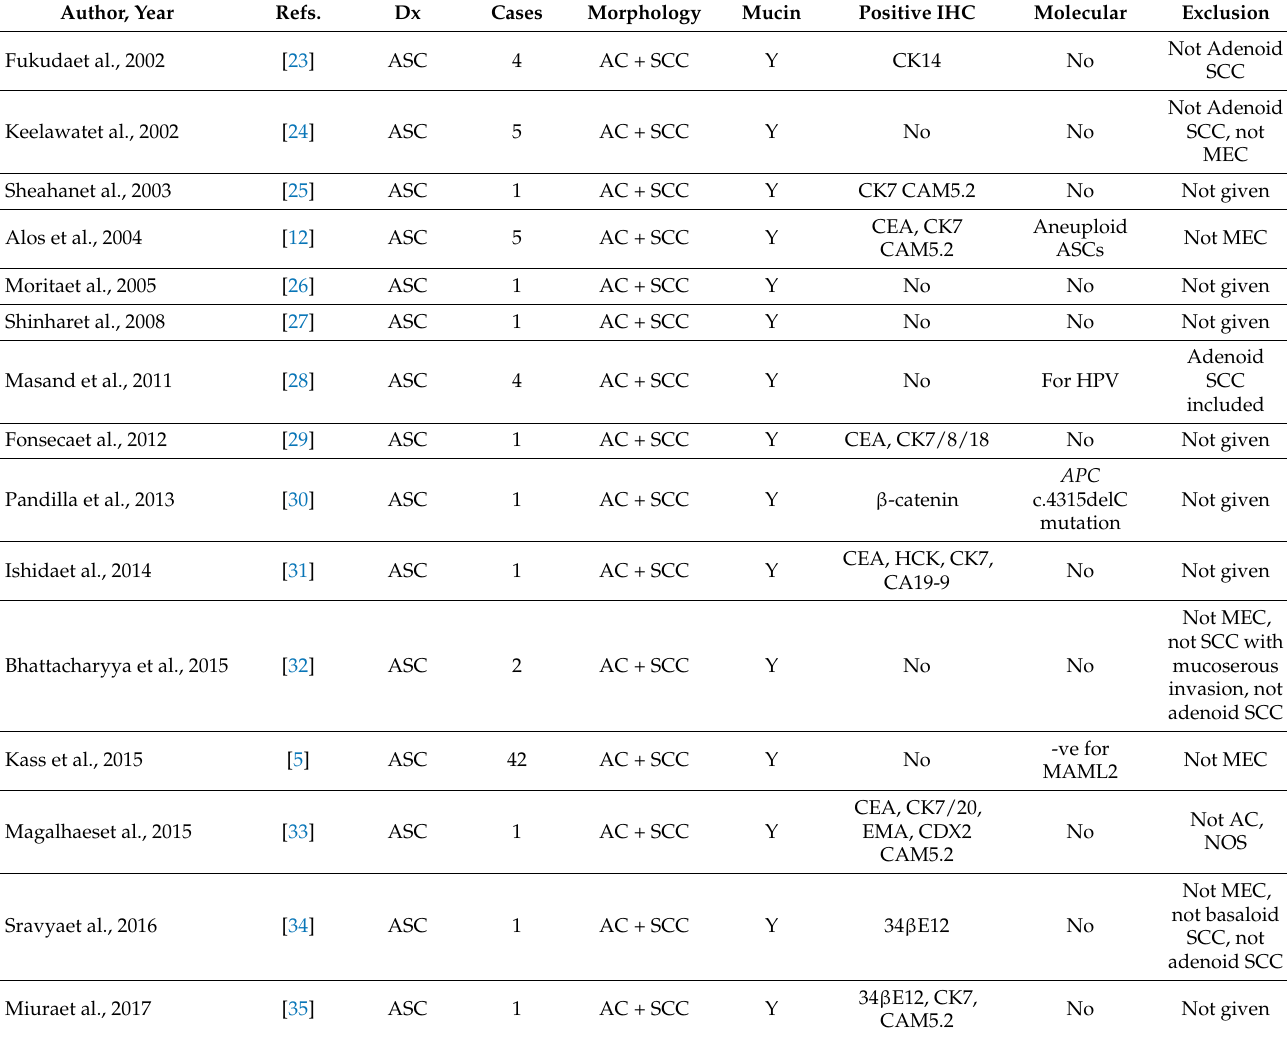
Table 1. Summary of the reviewed case of ASCs and MACs of the minor salivary